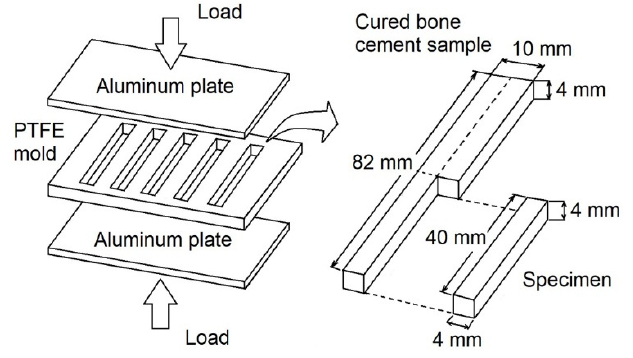
Figure 1. Schematic representation for the preparation of four-point bending test specimens.